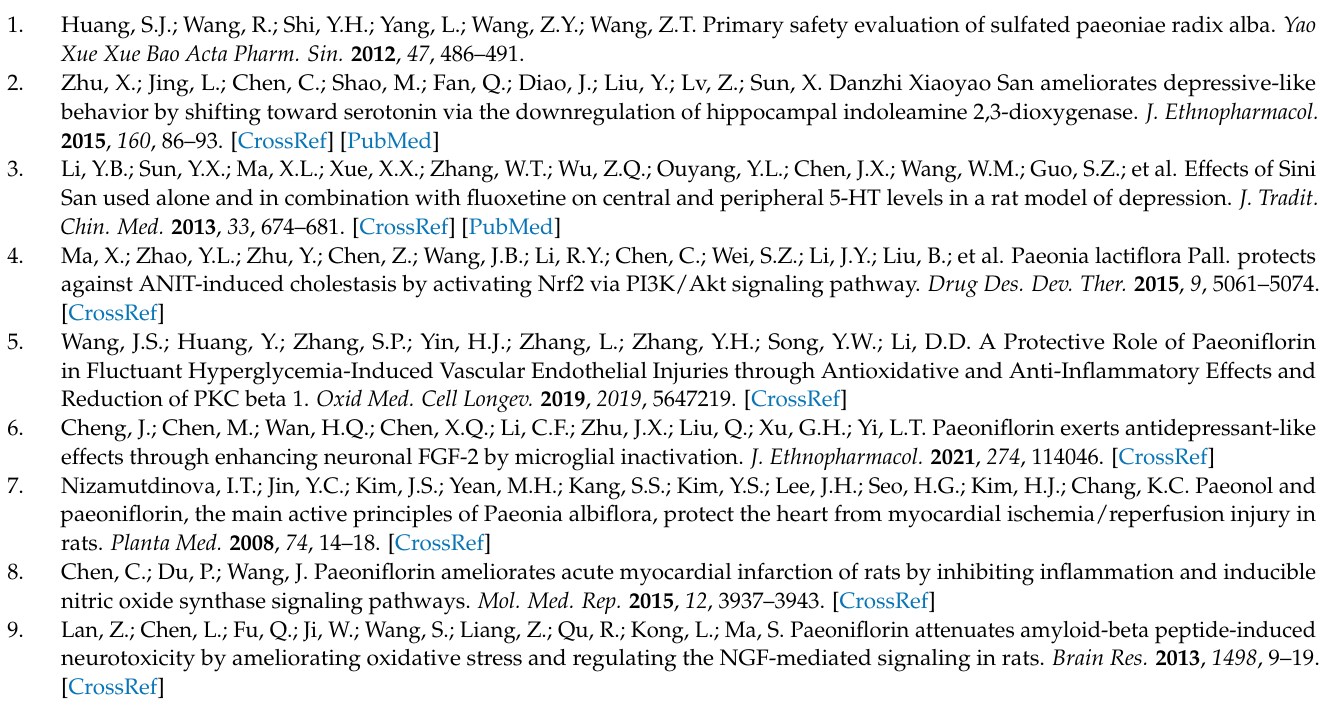
S2: MS analysis Results of B2; Table S3: MS analysis Results of B3; Table S4: Statistics of data output; Table S5: Statistics of differential gene